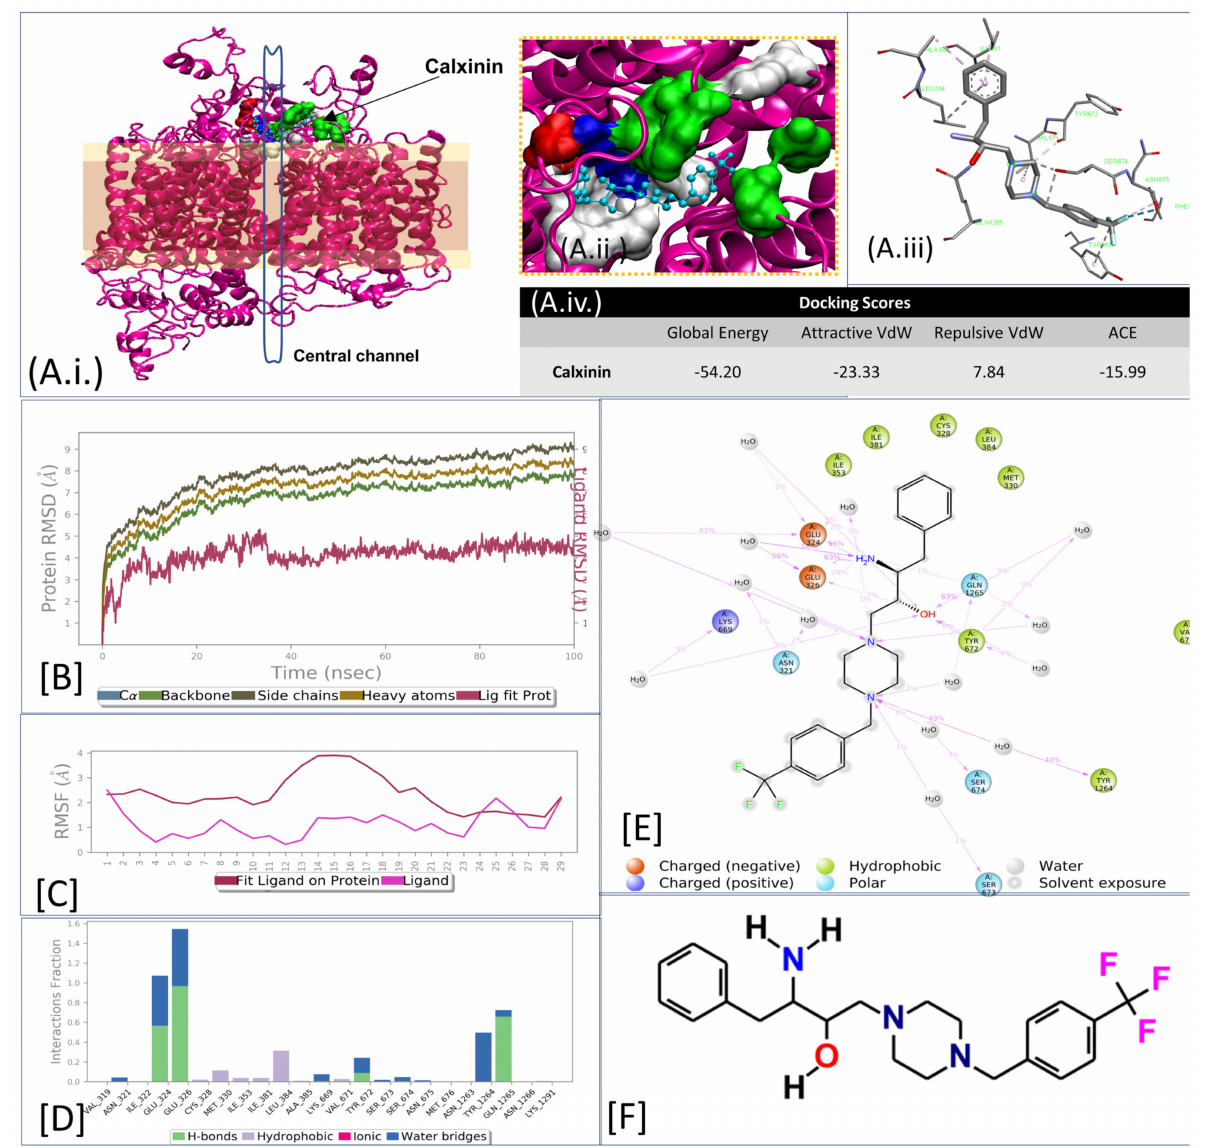
Figure 1. ( A ) Schematic representations of Calxinin docked at the active site ( i ) Active site amino acid molecular 3D topological positions and relative position of the central channel pore. Color and representation scheme: The protein backbone is mauve and in ribbon cartoon. ( ii ) Zoom-in view of binding pocket with docked ligands. Calxinin binding site is represented by amino acid side chain residues in surface structure colored by type (white: hydrophobic, green: polar, red: -ve, and blue: +ve charged), ( i , ii ). Calxinin is represented by CPK in sky blue color. Dashed lines show the blown-up frame of the docking site. ( iii ) Licorice styled wireframe model to show 3D interacting side-chain